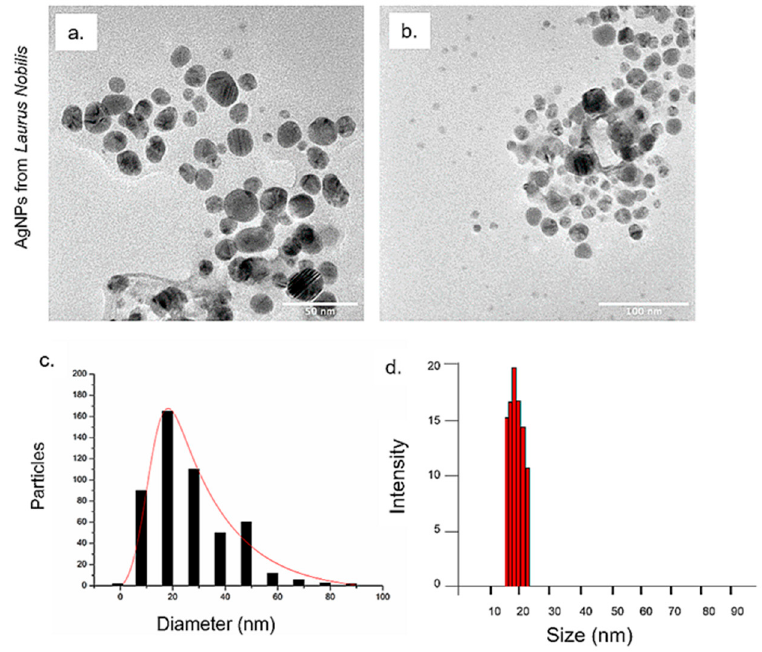
Figure 3. Representative TEM images of AgNPs obtained from Laurus Nobilis at pH 8 ( a – b ). Size distribution was measured on 500 AgNPs and fitted with a normal function (solid line) ( c ). DLS measurements in water of AgNPs from Laurus Nobilis at pH 8 ( d ).